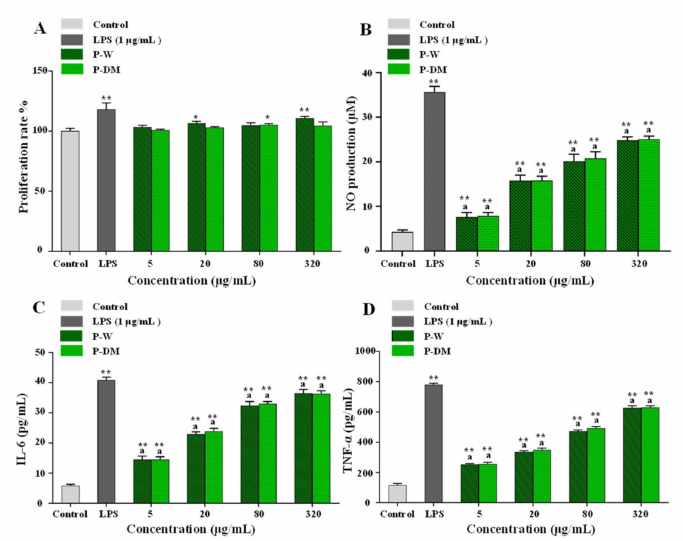
Figure 8. Effects of sweet tea polysaccharides on the proliferation ( A ), NO production ( B ), and cytokines (IL-6, C ; TNF- α , D ) released of RAW 264.7 cells. P-DM and P-W indicate polysaccharides extracted from sweet tea leaves by microwave-assisted deep eutectic solvent extraction and hot water extraction, respectively; Significant differences in cell proliferation and productions of NO, IL-6, and TNF- α in LPS, P-DM, and P-W vs. control are shown by * p < 0.05, ** p < 0.01. Significant differences ( p < 0.05) in productions of NO, IL-6, and TNF- α between P-DM and P-W are shown by data bearing different